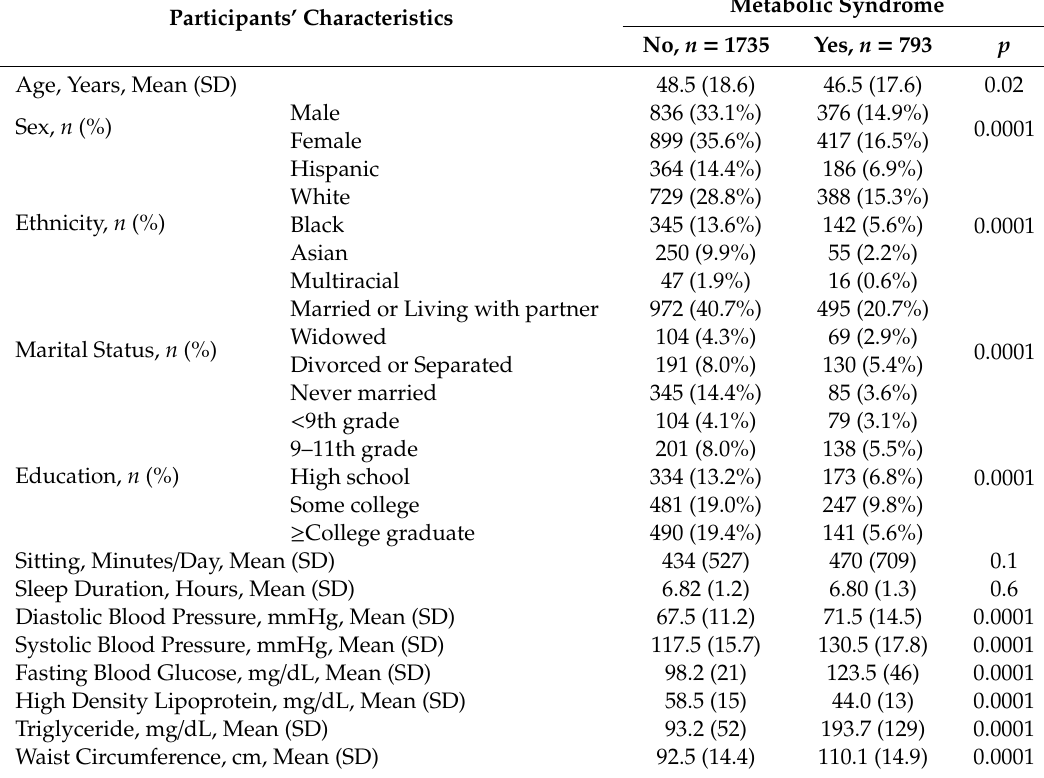
Table 1. Characteristics of participants in the National Health and Nutrition Examination Survey (NHANES) 2013 / 2014 according to metabolic